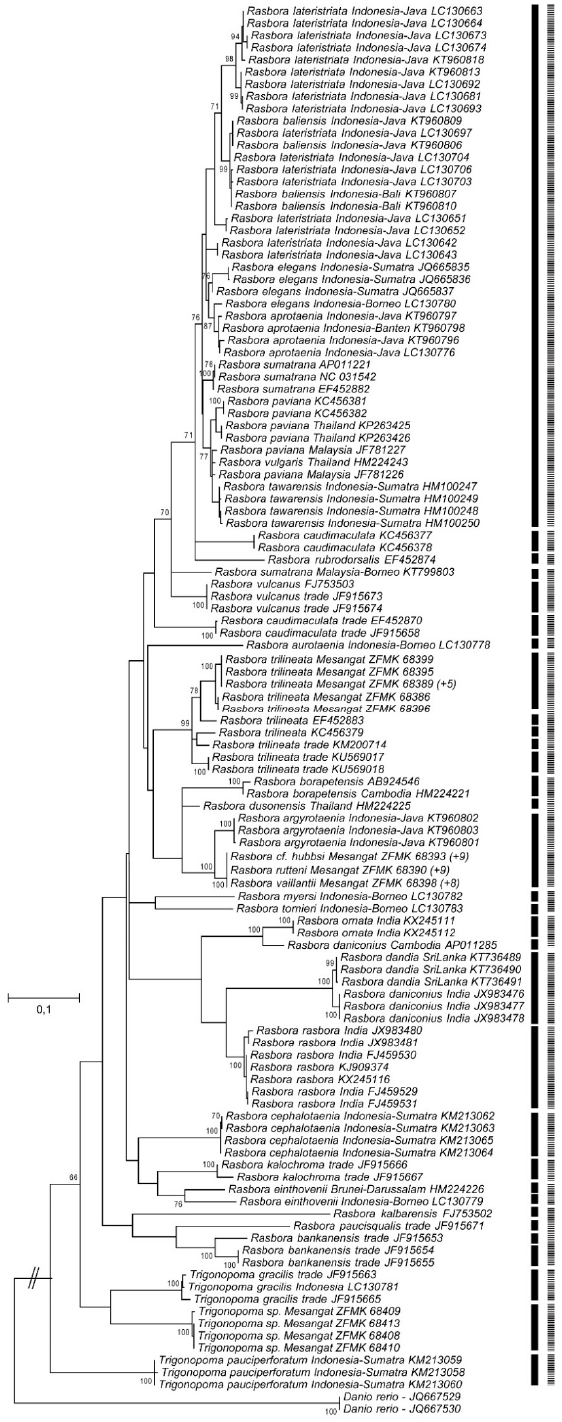
Figure 2. Maximum Likelihood estimation of the mitochondrial cytochrome oxidase I relationships with bootstrap support values above 65% based on 1000 pseudoreplicates (Hasegawa-Kishino-Yano model, 95% site coverage). For a better readability only up to three specimens per haplotype (i.e., identical COI sequence) have been included in the figure. The solid vertical bar indicates the species delimitation outcome using PTP (33 entities) and the dashed bar the species delimitation resulting from the mPTP approach (19 entities). If available from GenBank, country and sub-region has been included in specimen